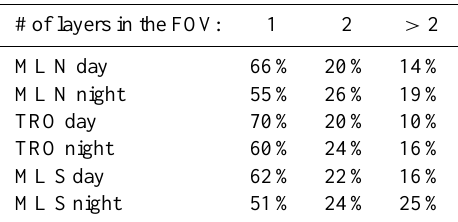
Fig. 3. Same as in Fig. 1 but for geometrically homogeneous cirrus clouds (the Final Database). Table 4. Coud overlap in the